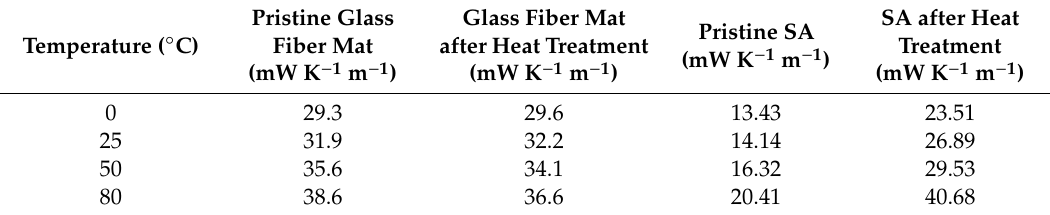
Figure 5. Temperature dependency of the thermal conductivity of fiber reinforced silica aerogel (FRSA) with B30 composites with and without heat treatment. All specimens measured via the heat flow meter (HFM) method. Table 2. Summary of the thermal conductivities of the pristine aerogel and the pristine glass fibers before and after heat